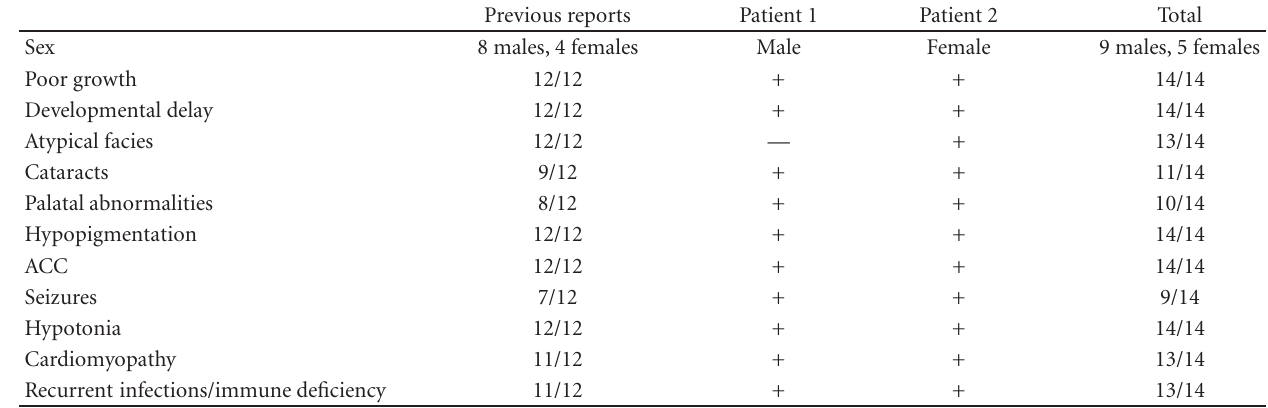
Table 1: Summary of clinical and imaging findings in patients with Vici syndrome.